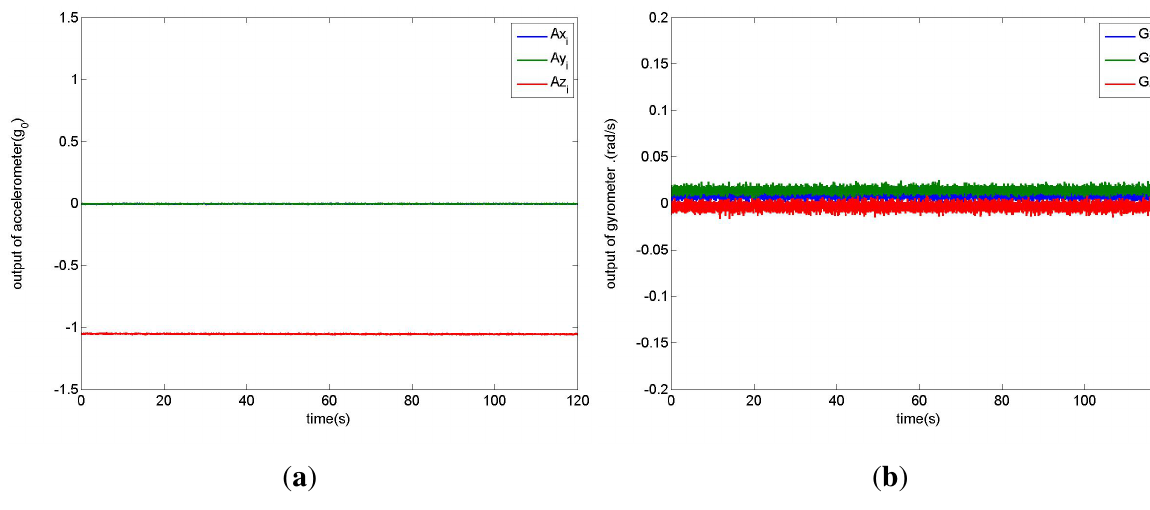
Figure 1. The direct outputs of triaxial ( a ) accelerometer and ( b )